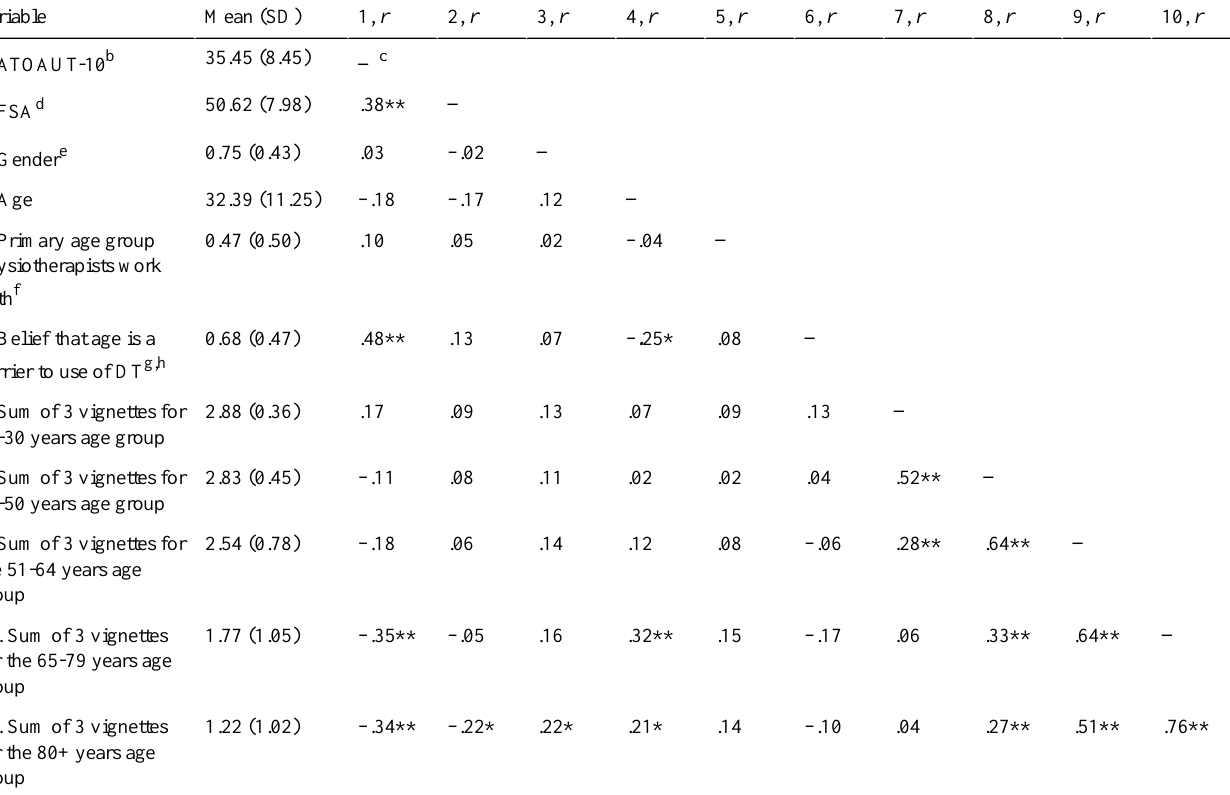
Table 2. Means, SDs, and correlations of the sum of the 3 vignettes for each age category, ATOAUT-10, FSA, and other variables (N= 95-97) a .